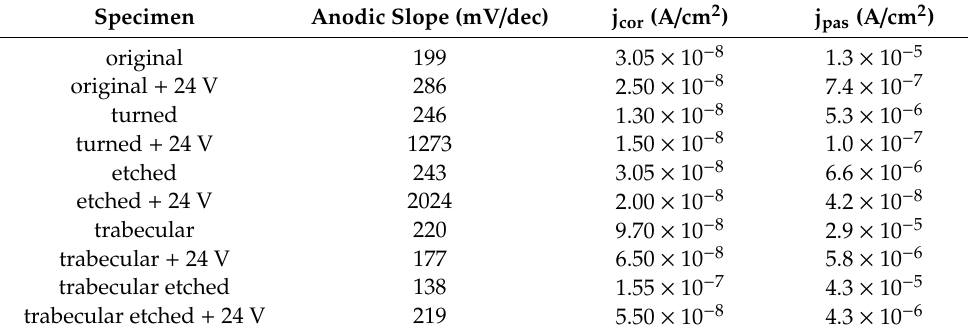
Table 2. Potentiodynamic curves